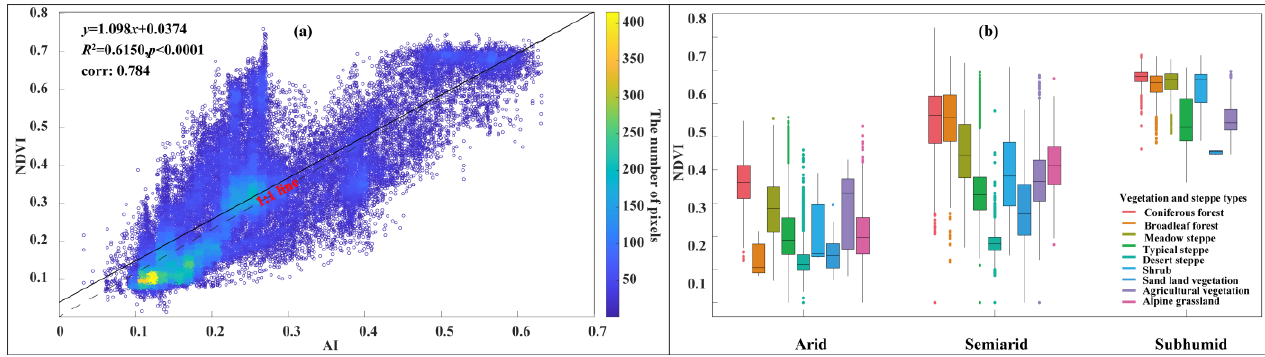
Figure 7. Variations in the annual NDVI gs in relation to the aridity index in the Mongolian Plateau. ( a ) the heatscatter plot of AI and NDVI, ( b ) the boxplot of NDVIgs for different vegetation and steppe types in sub climate regions.